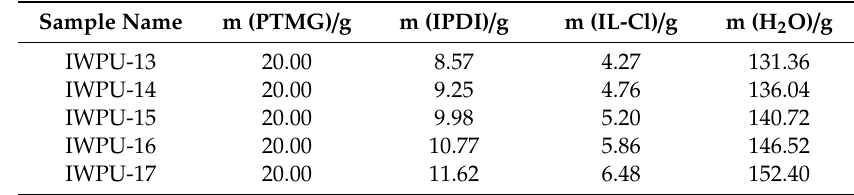
Table 1. The formula of IWPU prepared with di ff erent content of